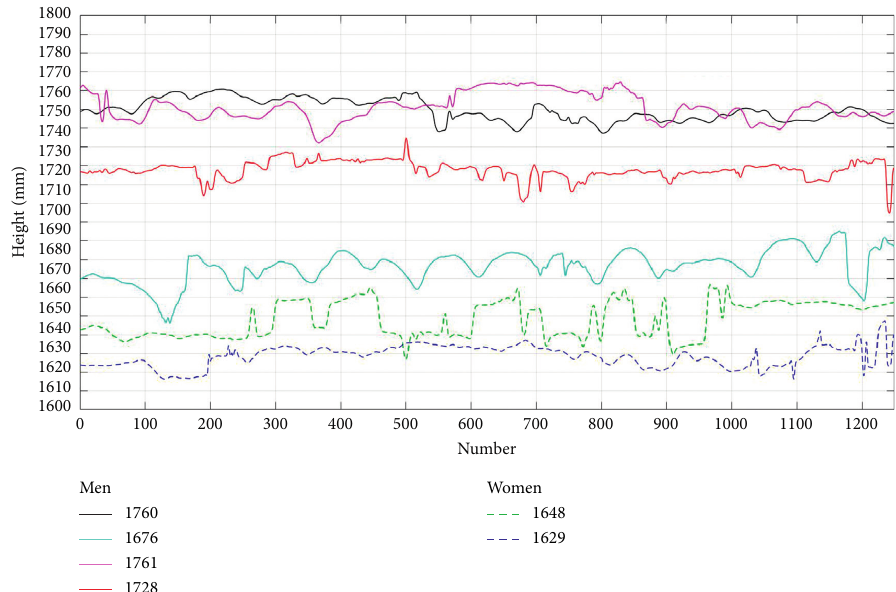
Figure 8: The height results got from the six subjects using the VICON alone in several continuous seconds.